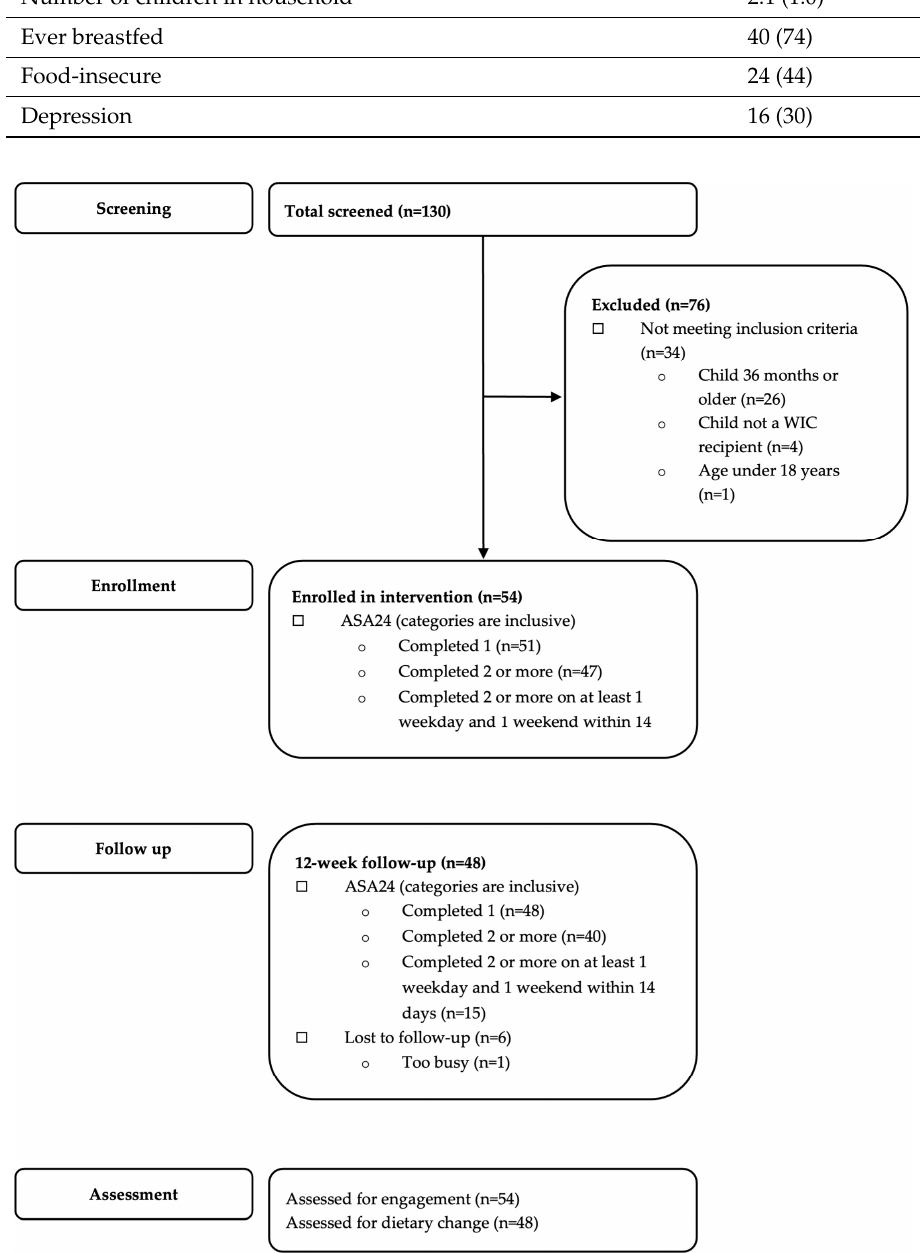
Figure 1. Healthy Roots Consort Diagram. Baseline Characteristics Participants (n = 54) were all women with a mean (SD) age of 31.1 (7.7) years and a mean (SD) BMI of 33.8 (9.7) kg/m 2 (Table 2). Most participants were white (63%), em- ployed or looking for work (63%), not married (57%), and had obesity (65%). Nearly half (44%) were food-insecure and over a quarter had some level of depression (30%).